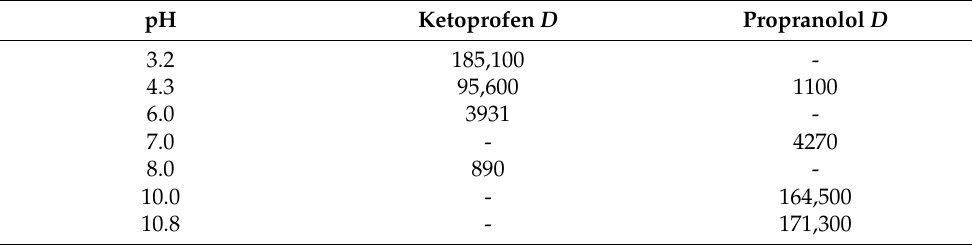
Table 1. Experimental overall distribution coefficients ( D ) of ketoprofen and of propranolol, in extraction experiments with 2 × 10 − 5 M starting concentration and with volume to mass ratio of 1000 µ L/mg.